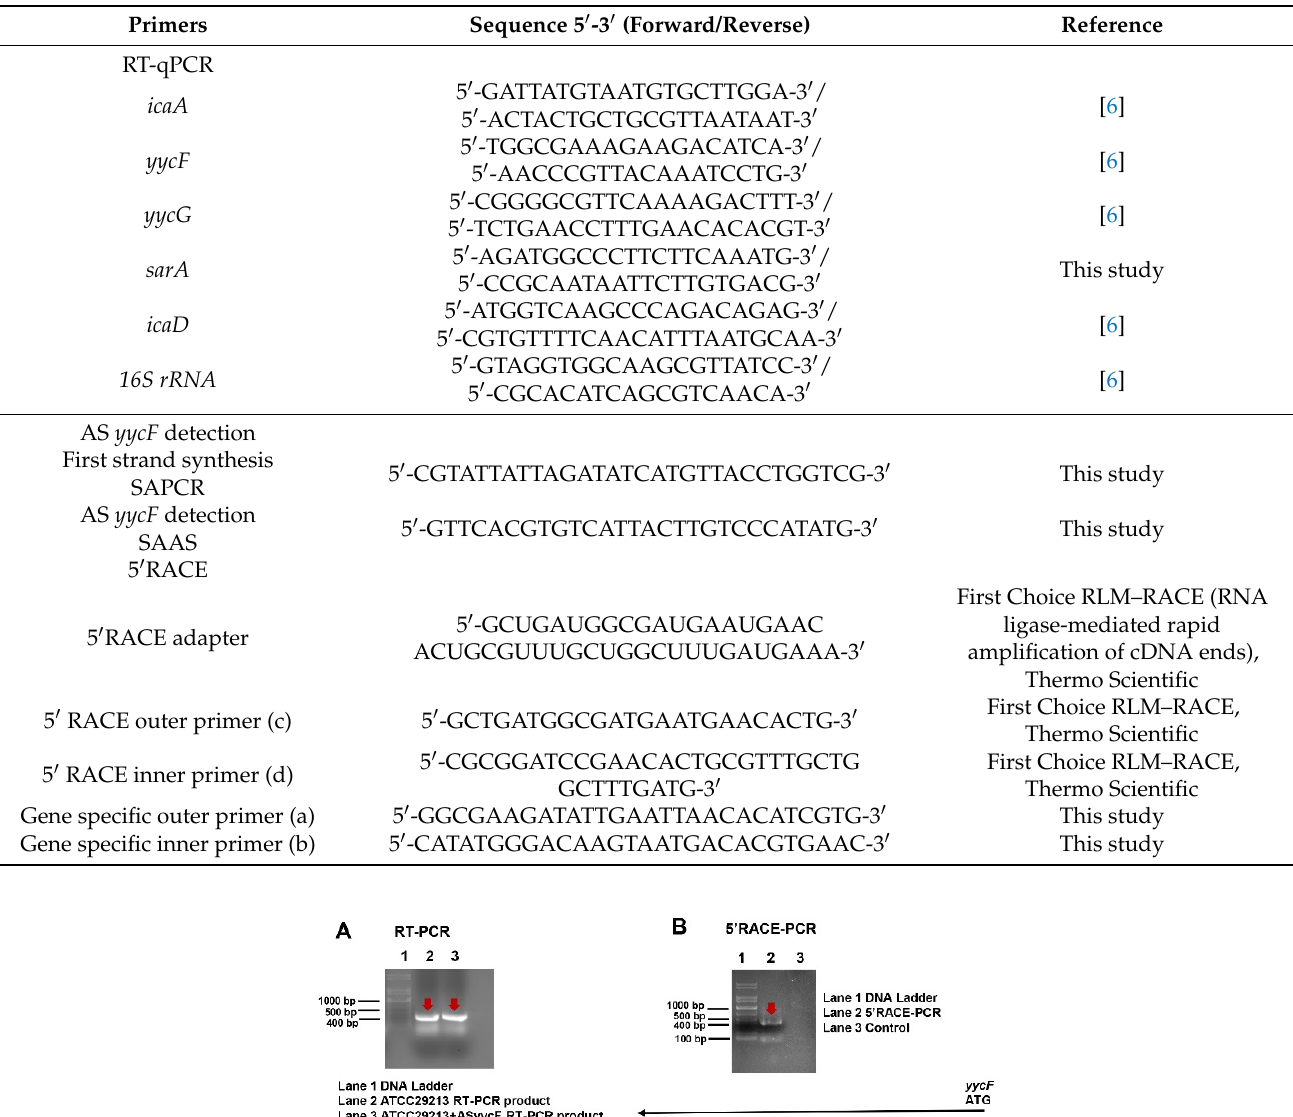
Table 1. Sequences of primers in this study.